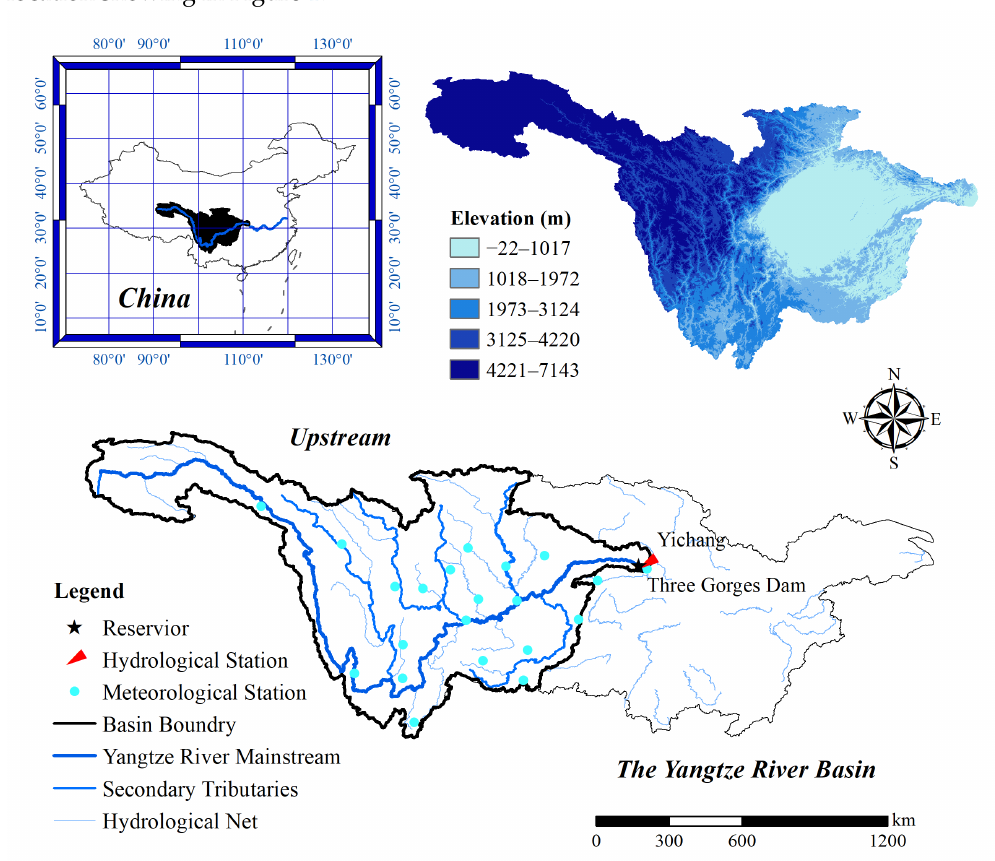
Figure 1. Geographic location and DEM map of the upstream Yangtze River basin with distribution of hydrological and meteorological stations for research